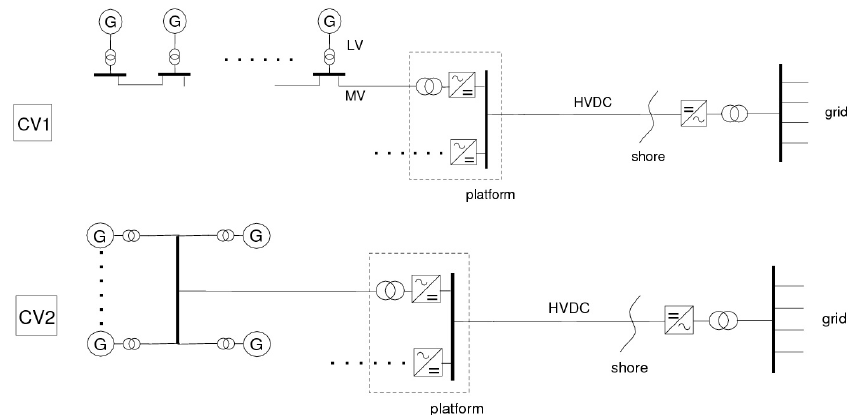
Figure 6 . Cluster-coupled variable-speed with HVDC